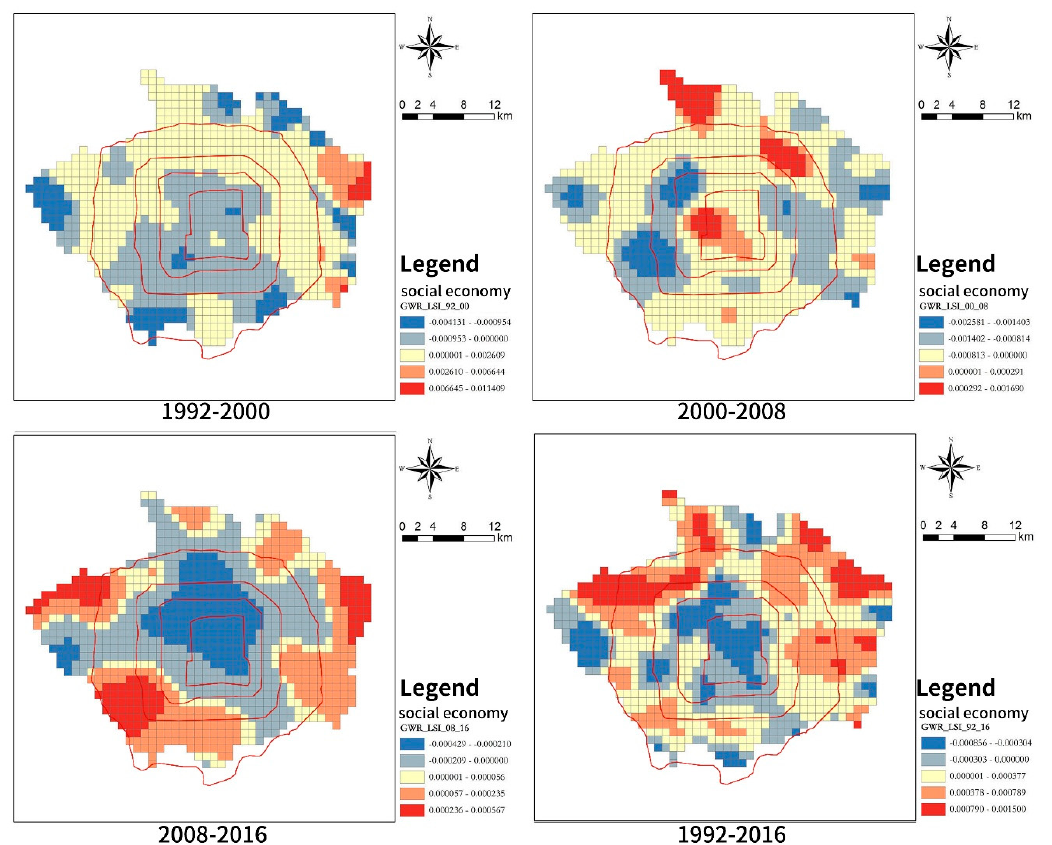
Figure 9. Spatial distribution map of coefficients between urbanization values and landscape shape index values of green spaces in central Beijing from 1992 to 2016.